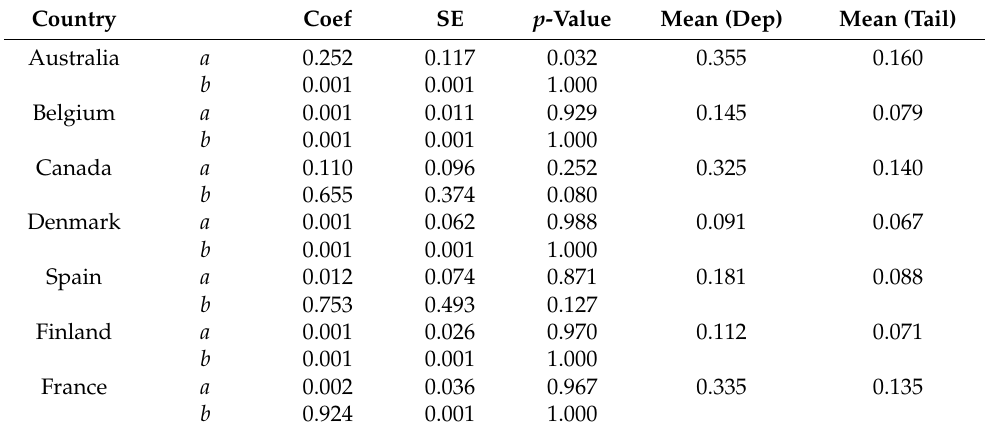
Table 9. The results of the DCC copula part.